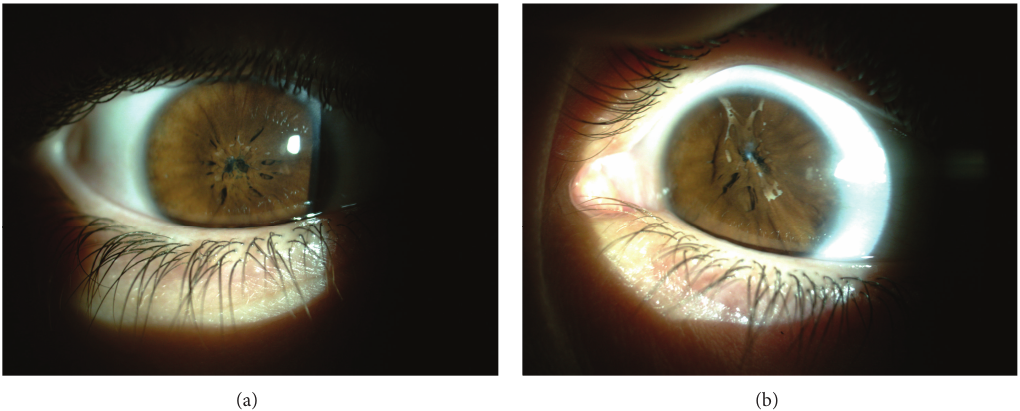
Figure 1: Congenital persistent pupillary membranes were covering the central pupil in the right eye (a) and in the left eye (b).